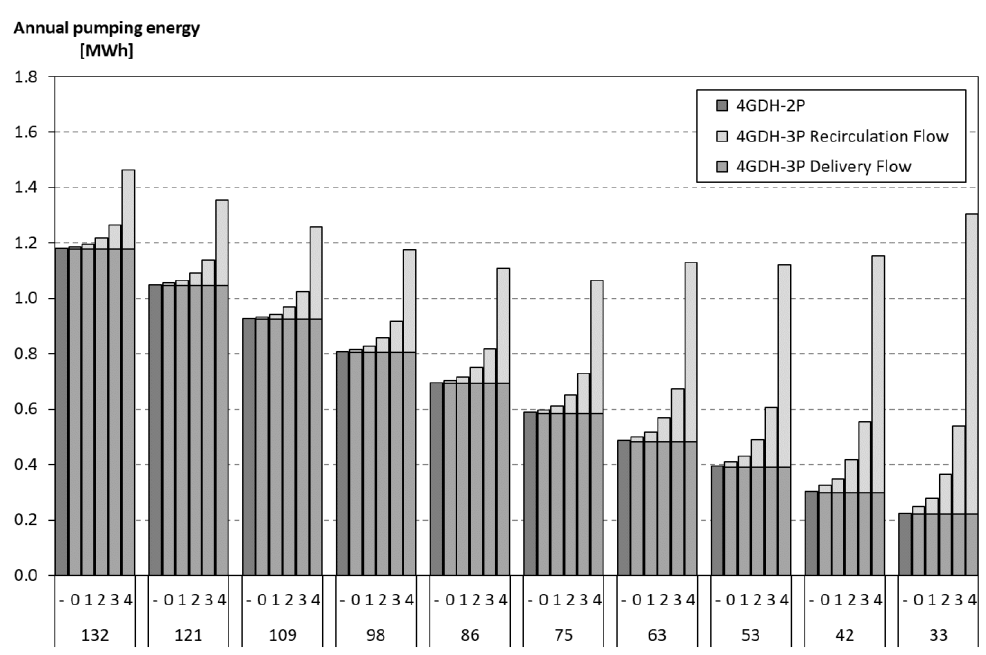
Figure 10. Annual pumping energy for the case area at NTU (8/1) for heat exchangers in substations and radiators for 10 different annual specific heat demands (132–33) [kWh/m 2 , a]. The dash (-) denotes the performance for the current two-pipe distribution (4GDH-2P), while 0–4 denote the three-pipe distributions with the corresponding downward displacement of the standard sizes for the third pipe.